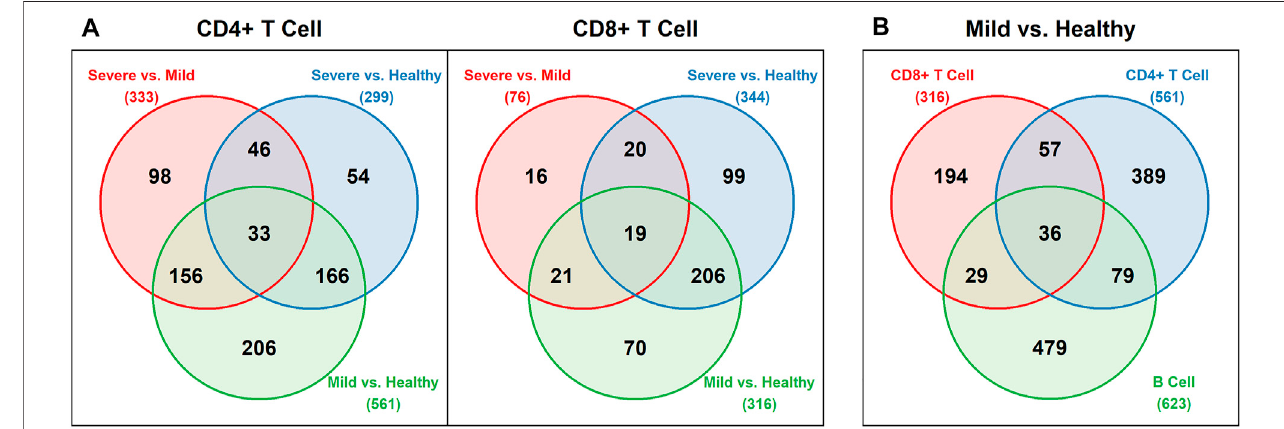
FIGURE2| VenndiagramsforDEgenes (A) Pairwisecomparisonsofthehealthy,mild,andseveregroupsforCD4 + andCD8 + Tcells (B) Comparisonofthemildvs healthy group for CD4 + T cells, CD8 + T cells, and B cells.